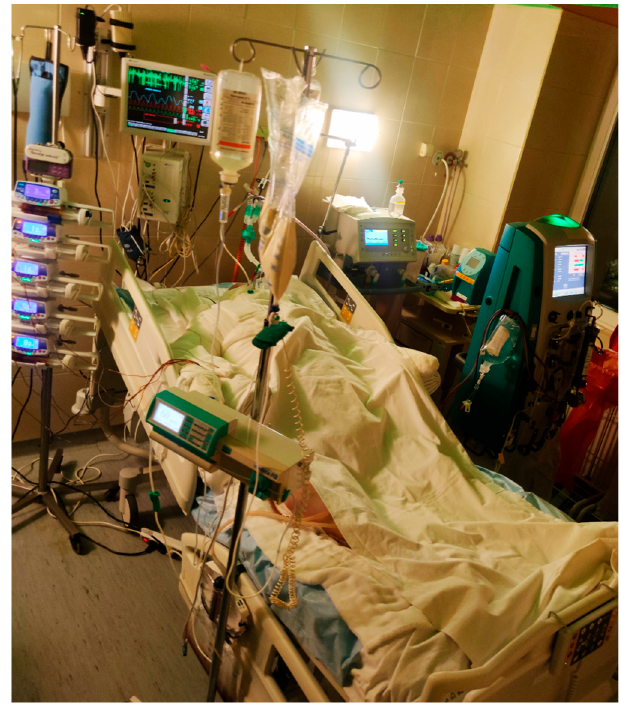
Figure 3. Alternative nutrition in patients with burn injury.